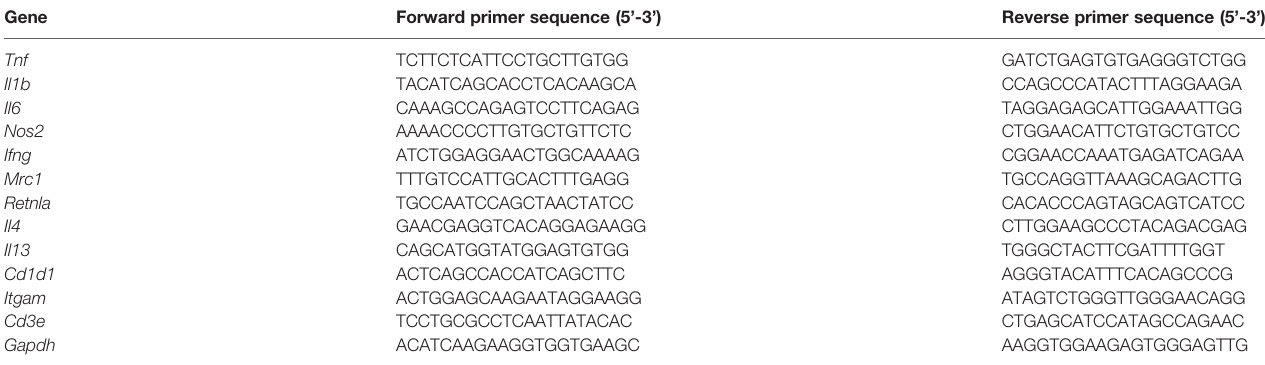
TABLE 1 | Primers used for reverse transcription and quantitative